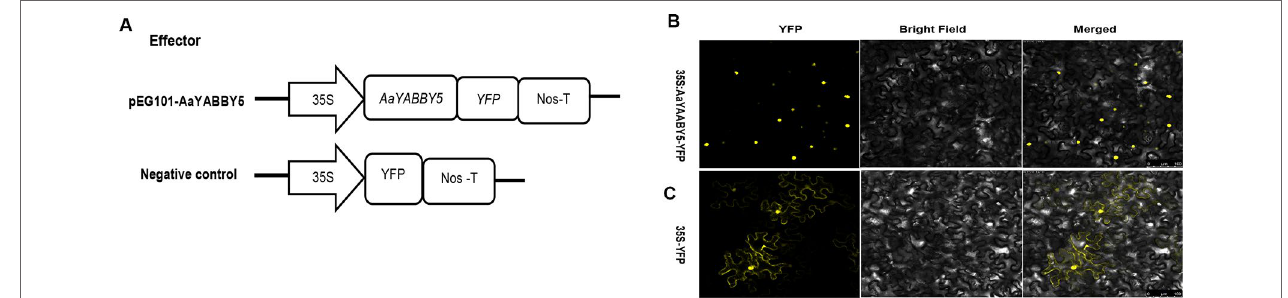
FIGURE 3 | Subcellular localization of AaYABBY5 protein. (A) The sketch map shows the constructs used for finding subcellular localization. (B) Subcellular localization found under confocal laser microscope using leaf cells of Nicotiana benthamiana after infiltration. AaYABBY5 was found localized to the nucleus in